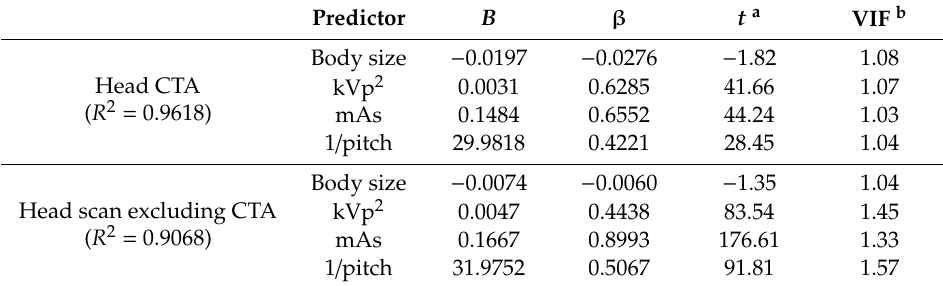
Table 4. Results of multivariate analysis for the head scans performed using MDCT 64 .